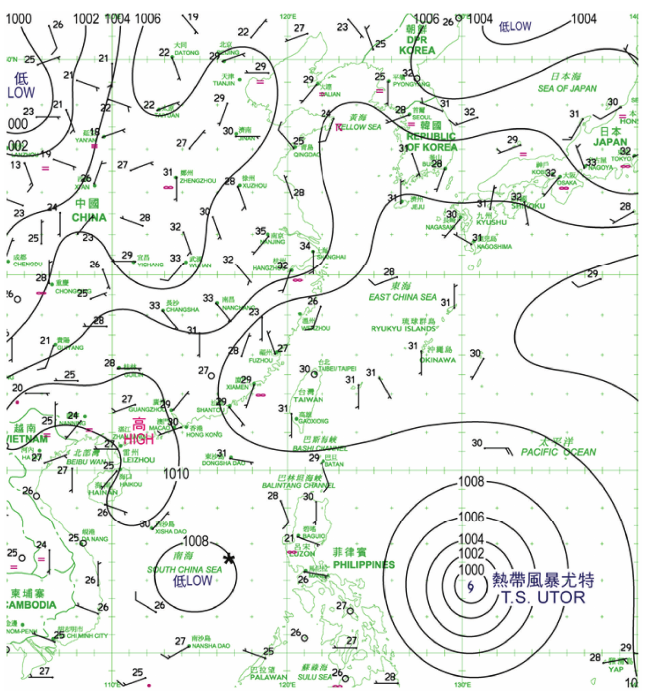
Figure 1: Surface isobaric chart at 00 UTC, 10 August 2013. The asterisk shows the location of the severe turbulence event.